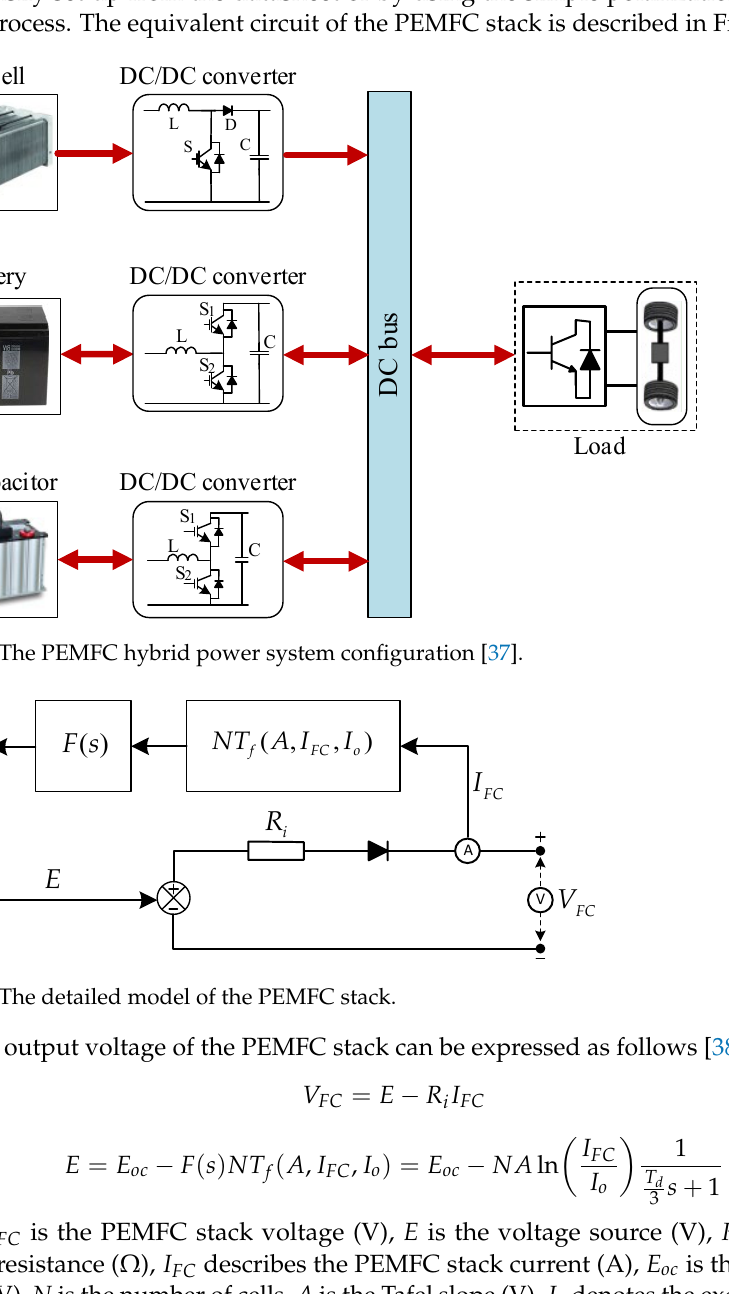
Figure 2. The detailed model of the PEMFC stack.